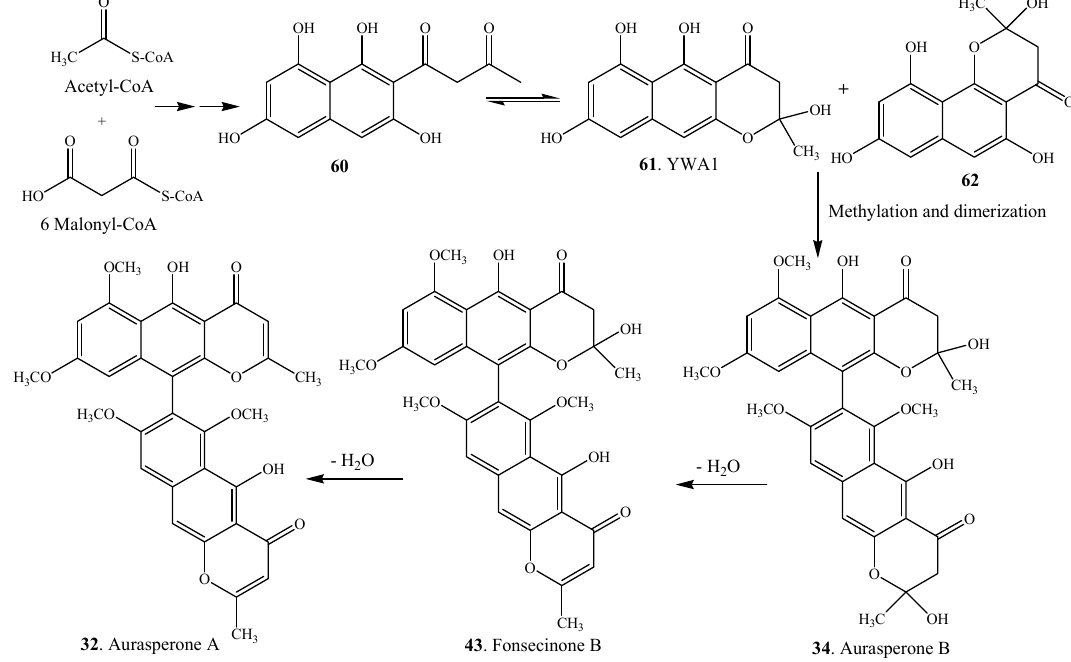
Scheme 1. Proposed biosynthetic pathway of asperpyrone-type bis-naphtho- γ -pyrones in Aspergillus niger [33].